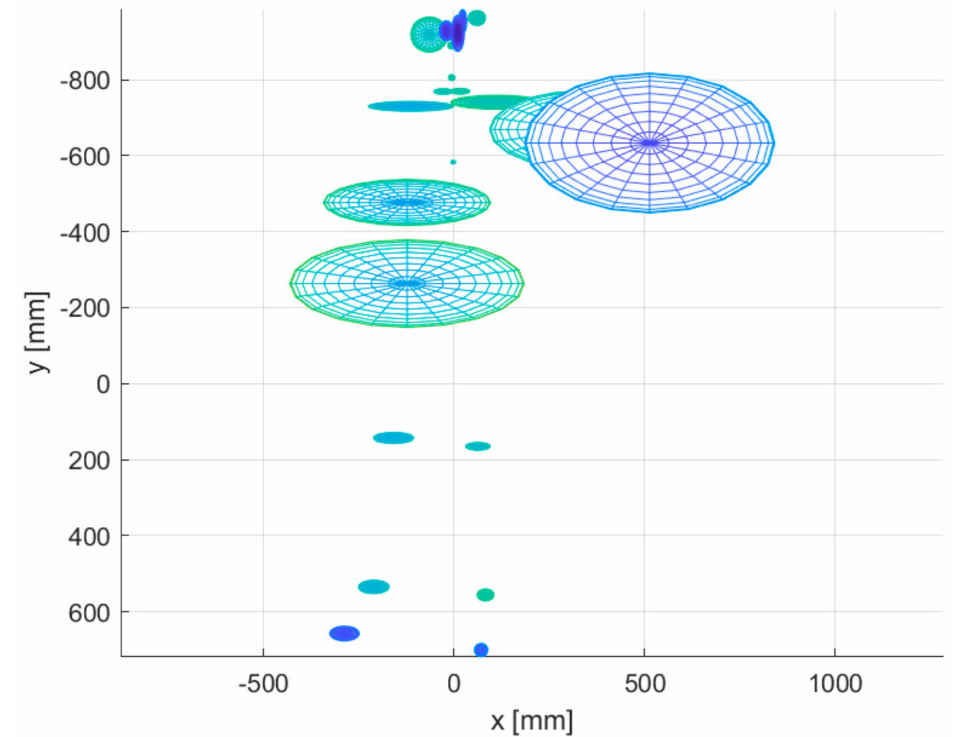
Figure 23. Body joint noise of Azure Kinect in the WFOV